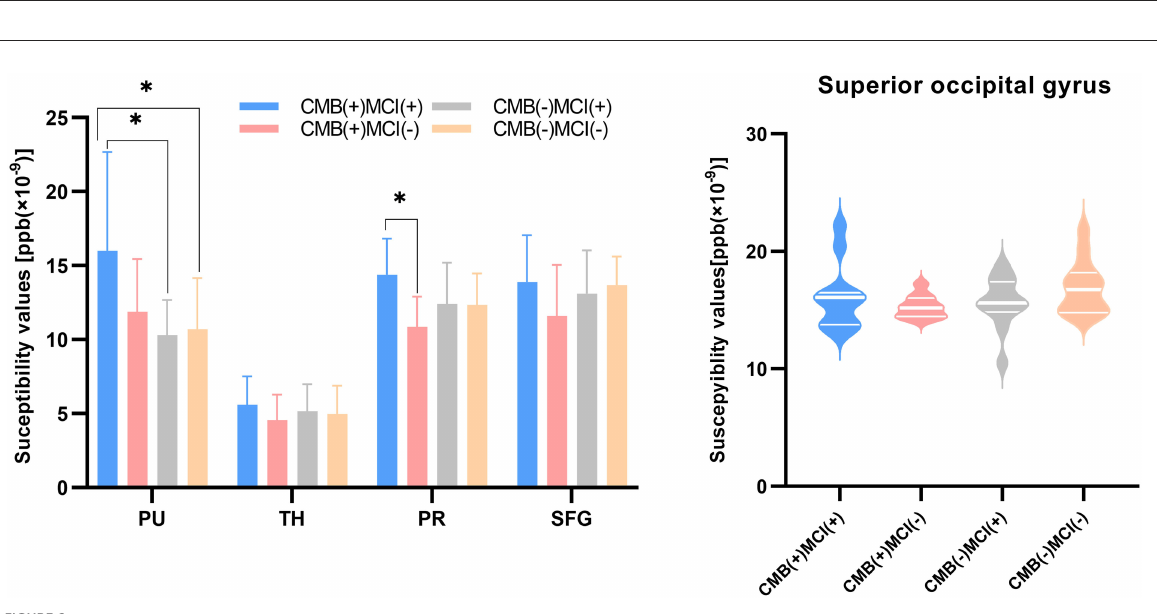
FIGURE6 The iron content of rich-club nodes (grouped by the presence of CMB or MCI). The histogram expresses normal distribution data; “T” denotes standard deviation. The violin diagram expresses abnormal distribution data; three transverse lines denote the 75th percentile, median, and 25th percentile (top to bottom). * p -value <